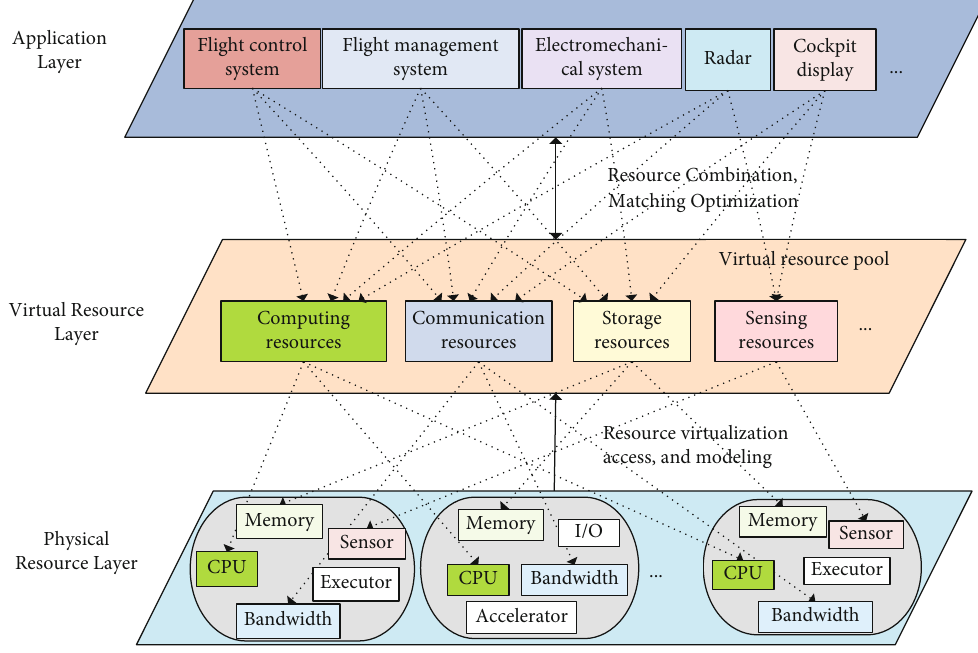
Figure 1: Resource organizational framework based on virtual resource